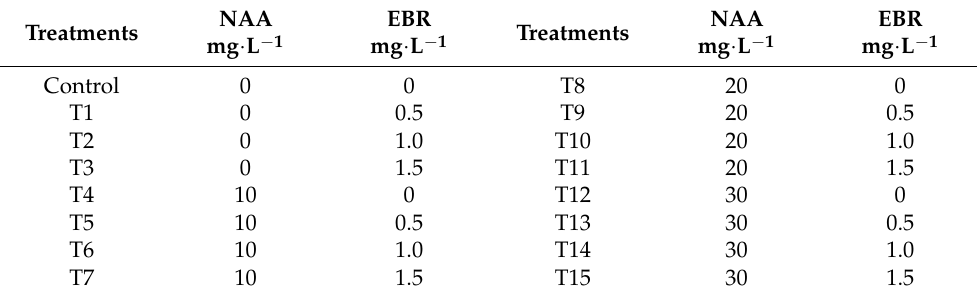
Table 1. Different combinations of NAA and EBR.